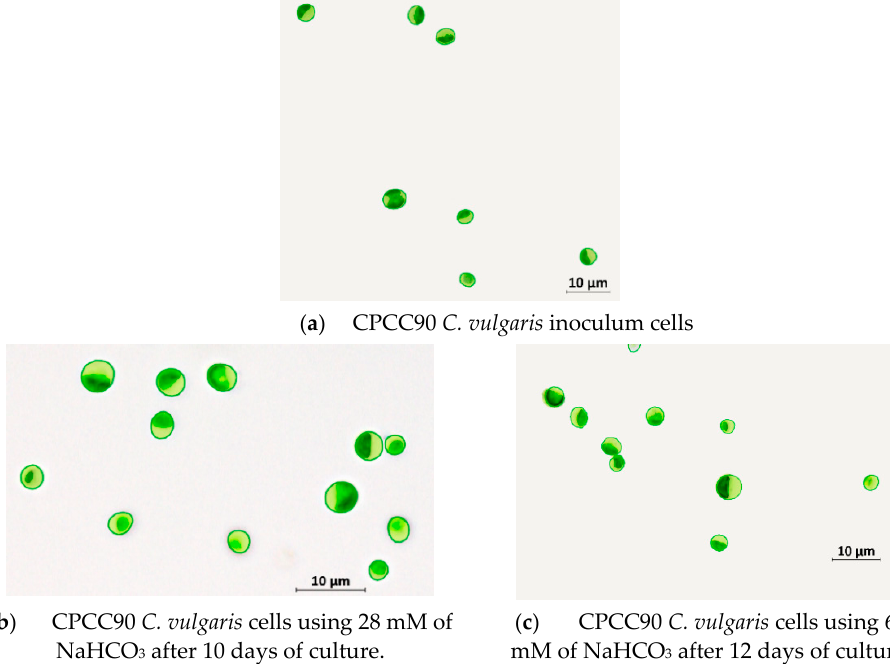
Figure 2. Microscope images of CPCC90 Chlorella Vulgaris cells: ( a ) Inoculum cells, ( b ) a case where a 28 mM NaHCO 3 solution was used and after 10 days of culture, ( c ) a case where a 60 mM NaHCO 3 solution was used and after 12 days of culture (contrast and cell boundary definition have been modified to improve the resolution of the images).